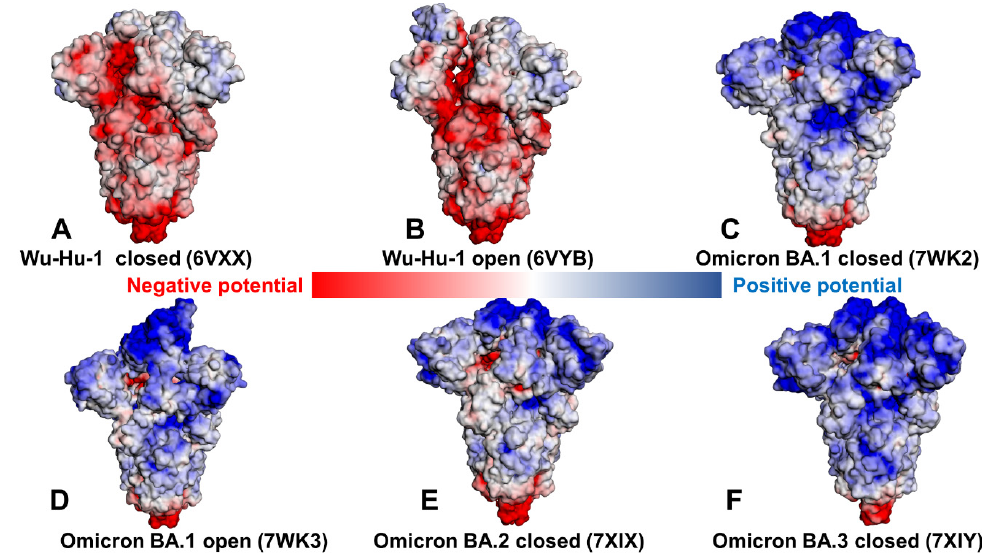
Figure 5. The distribution of the electrostatic potentials calculated with the APBS method [83,84] on the molecular surface of trimeric S proteins of Wuhan strain (Wu-Hu-1) closed state, pdb id 6VXX ( A ), S-Wu-Hu-1 trimer in the open state, pdb id 6VYB ( B ), S-Omicron BA.1 closed trimer, pdb id 7WK2 ( C ), S-Omicron BA.1 open 1-up trimer, pdb id 7WK3 ( D ), S-Omicron BA.2 closed trimer, pdb id 7XIX ( E ), and S-Omicron BA.3 closed trimer, pdb id 7XIY ( F ). The color scale of the electrostatic potential surface is in units of kT/e at T = 37 ◦ C. Electro-positively and electronegatively charged areas are colored in blue and red, respectively. Neutral residues are in